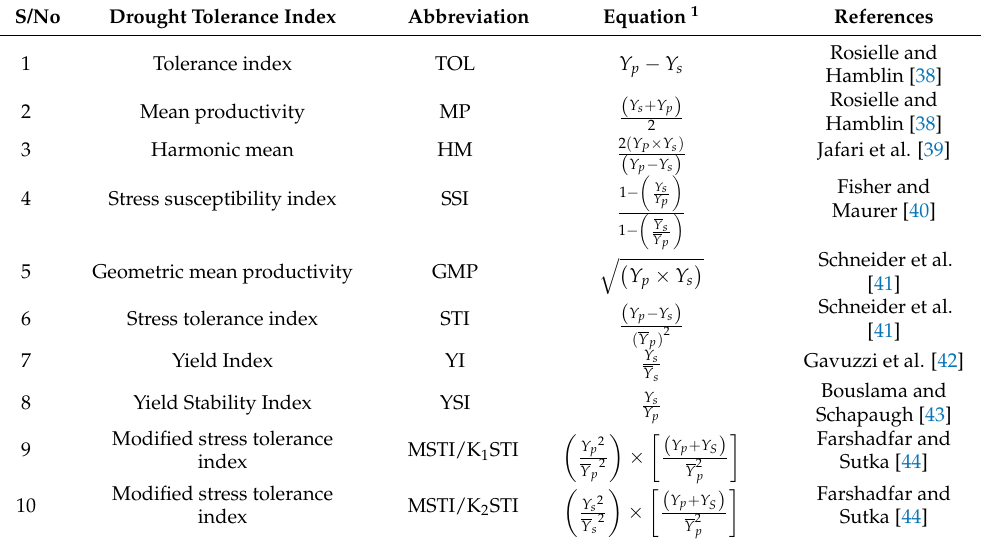
Table 1. Drought tolerance/susceptibility indices used to evaluate 225 African sorghum genotypes. S/No Drought Tolerance Index Abbreviation Equation